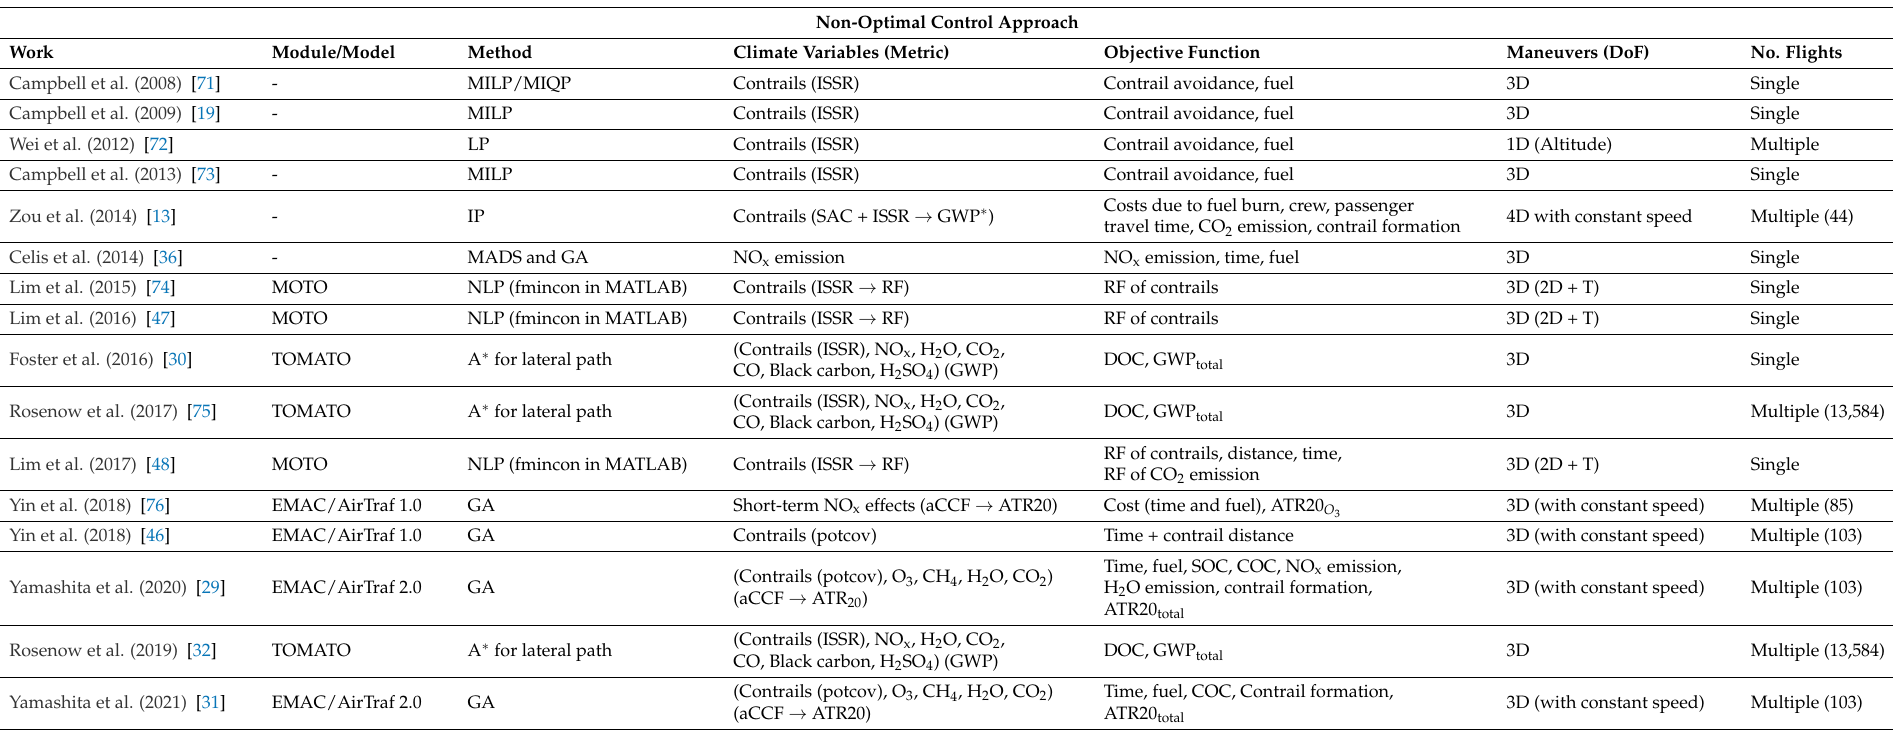
Table 2. Non-optimal control strategies proposed in the literature for climate optimal